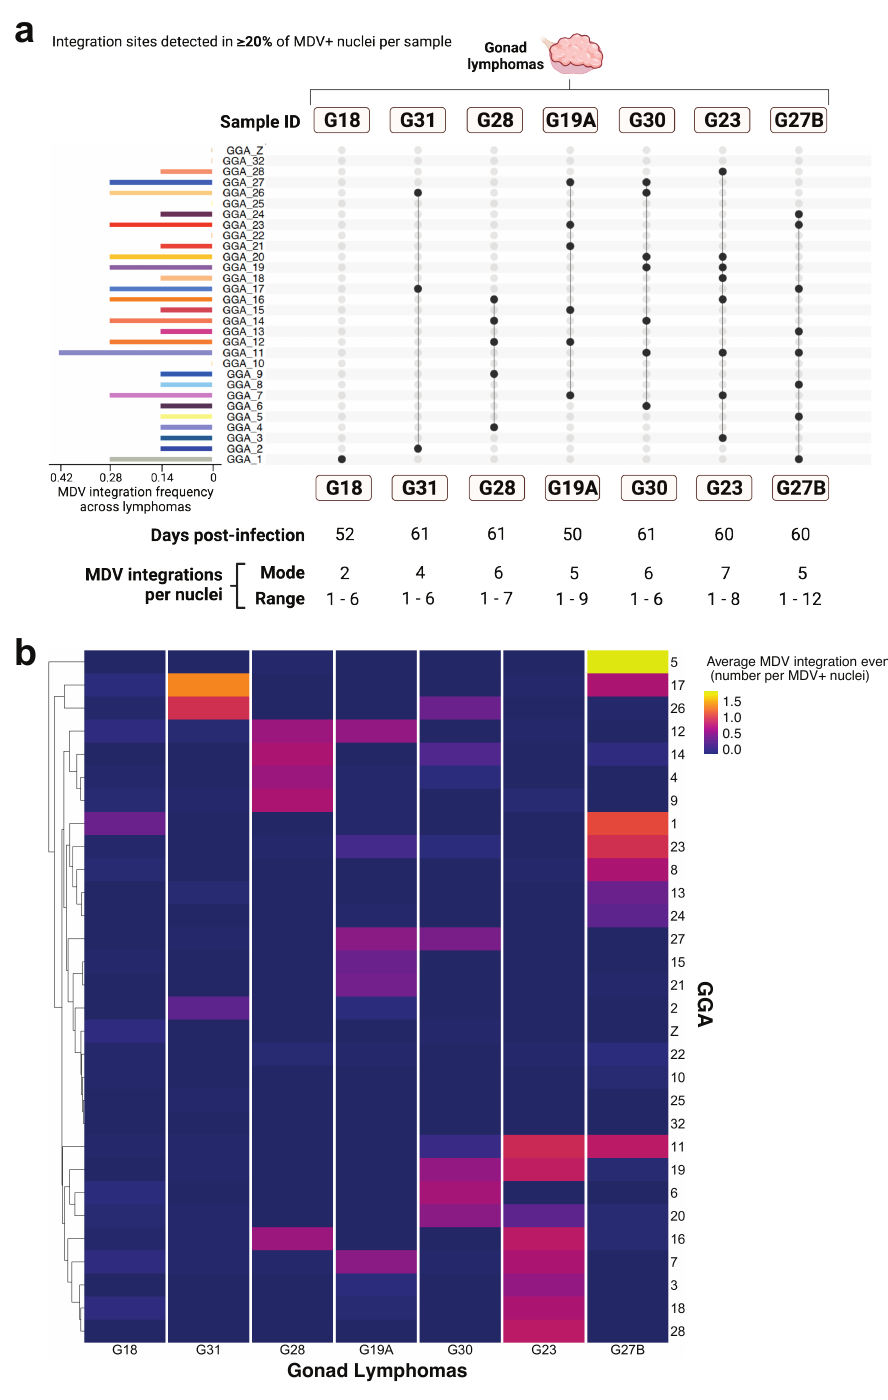
Figure 3. MDV FISH analysis indicates heterogenous inter-individual MDV integration profiles among MD gonad lymphomas from different birds: ( a ) Left bar graph panel shows the frequency of each host chromosome site among MDV integration profiles of gonad lymphomas in study part II. Dot plot (right panel) indicates the profiles of MDV integration at host chromosome sites detected in >20% of MDV-positive (MDV + ) nuclei from each individual gonad lymphoma (e.g., G18, G31, etc.) of a different MDV-infected bird (study part II; see Figure 1a). Tissue collection timepoints post MDV infection (dpi), and the mode and range of MDV integrations per nuclei are indicated below the dot plot for each lymphoma; ( b ) Average MDV integrations events (as counts) per MDV + nuclei for each host chromosome ( y axis) for MD gonad lymphomas ( x axis) from individual birds in study part II. Y axis (with host chromosome sites) is organized by unsupervised hierarchical clustering, which means a deep learning algorithm identified a hierarchy of natural groups within the